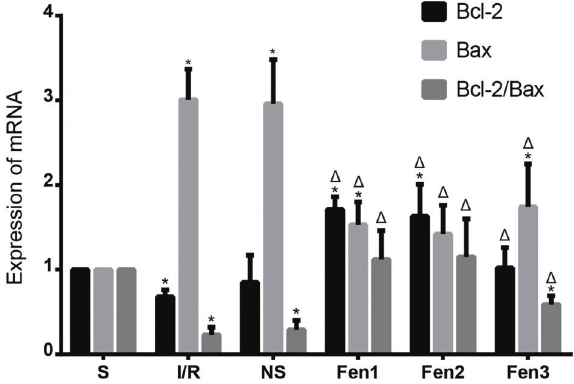
Figure 7. Bcl-2 and Bax mRNA expressions, and Bcl-2/Bax ratio in the sham operation (S) group, ischemia-reperfusion (I/R) group, normal saline (NS) group, and fentanyl (Fen)1 group (2 m g/kg), Fen2 group (4 m g/kg), and Fen3 group (6 m g/kg). Bcl-2: